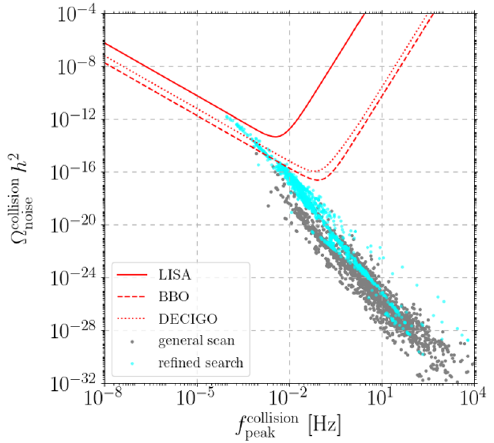
Figure 8 . The points from the general scan are shown in gray while the points generated by re(cid:12)ned scanning are shown in